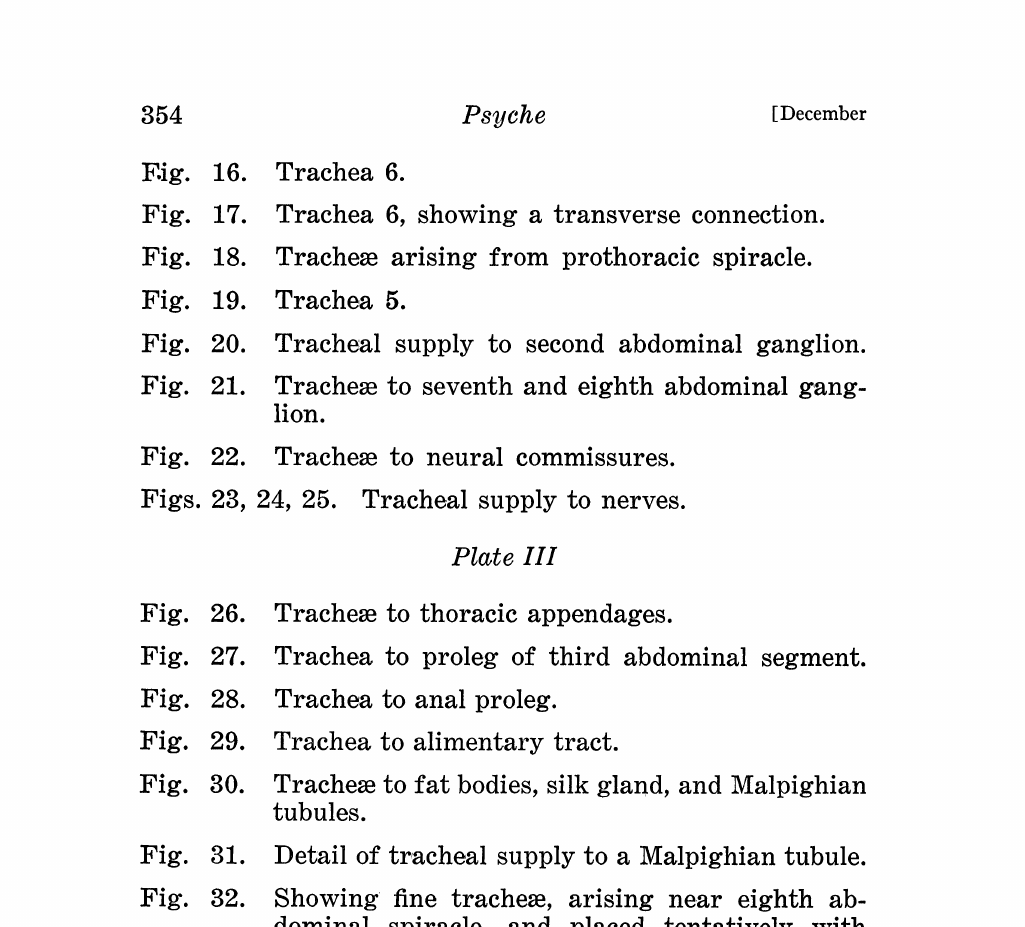
Fig. 31. Detail of tracheal supply to a Malpighian tubule. Fig. 32. Showing fine trachese, arising near eighth ab- dominal spiracle, and placed tentatively